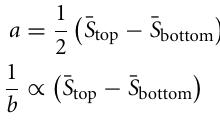
FIGURE 1 | Schematic of feedback trials. (A) Target appears for 2s (indicating goal of current trial); (B) cursor appears for 3s while real-time coherence is calculated; (C) for 5s the cursor moves in the x direction at a constant speed and y velocity is determined by